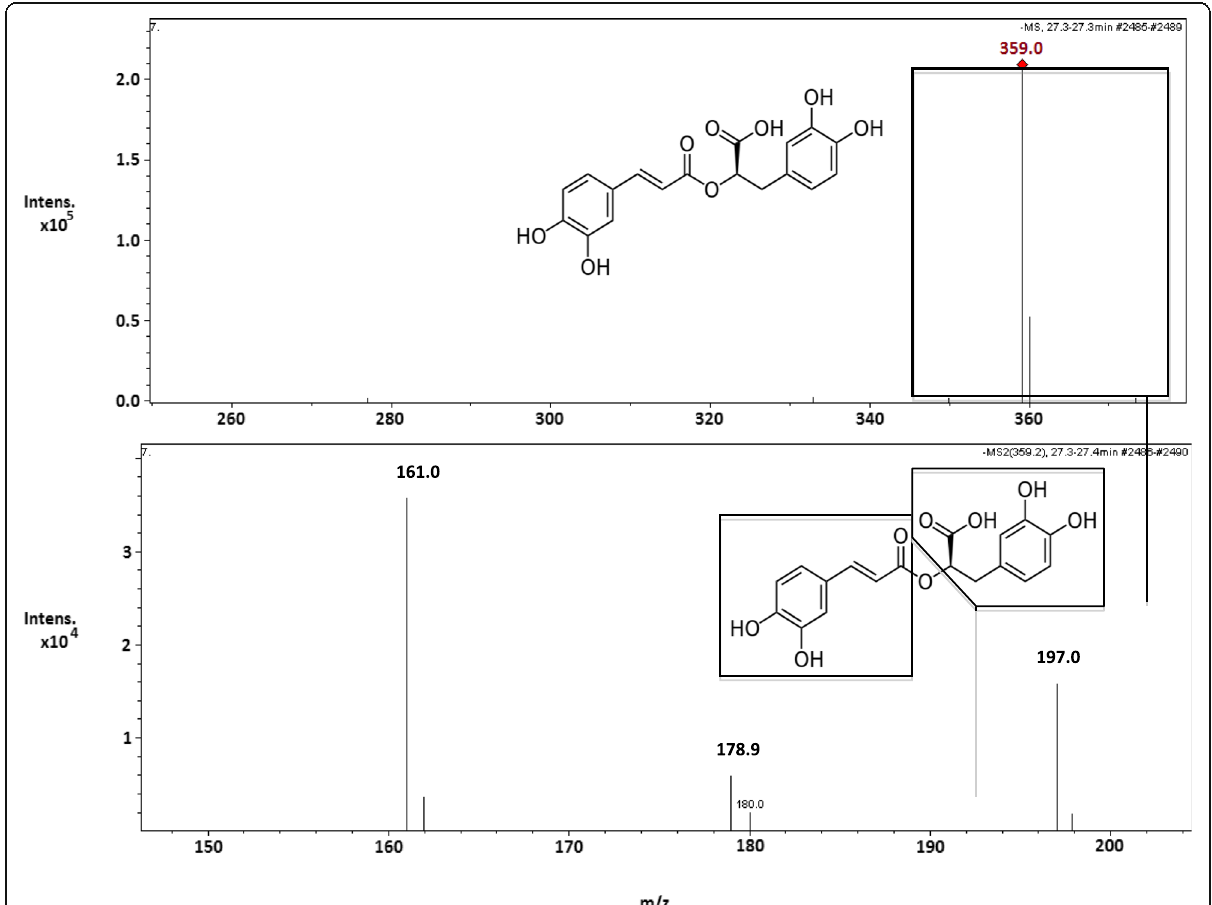
Fig. 5 ESI-MS/MS spectra of peak no. 4 in the non-dechlorophyllized Medina soluble phenolics sample (identified as rosmarinic